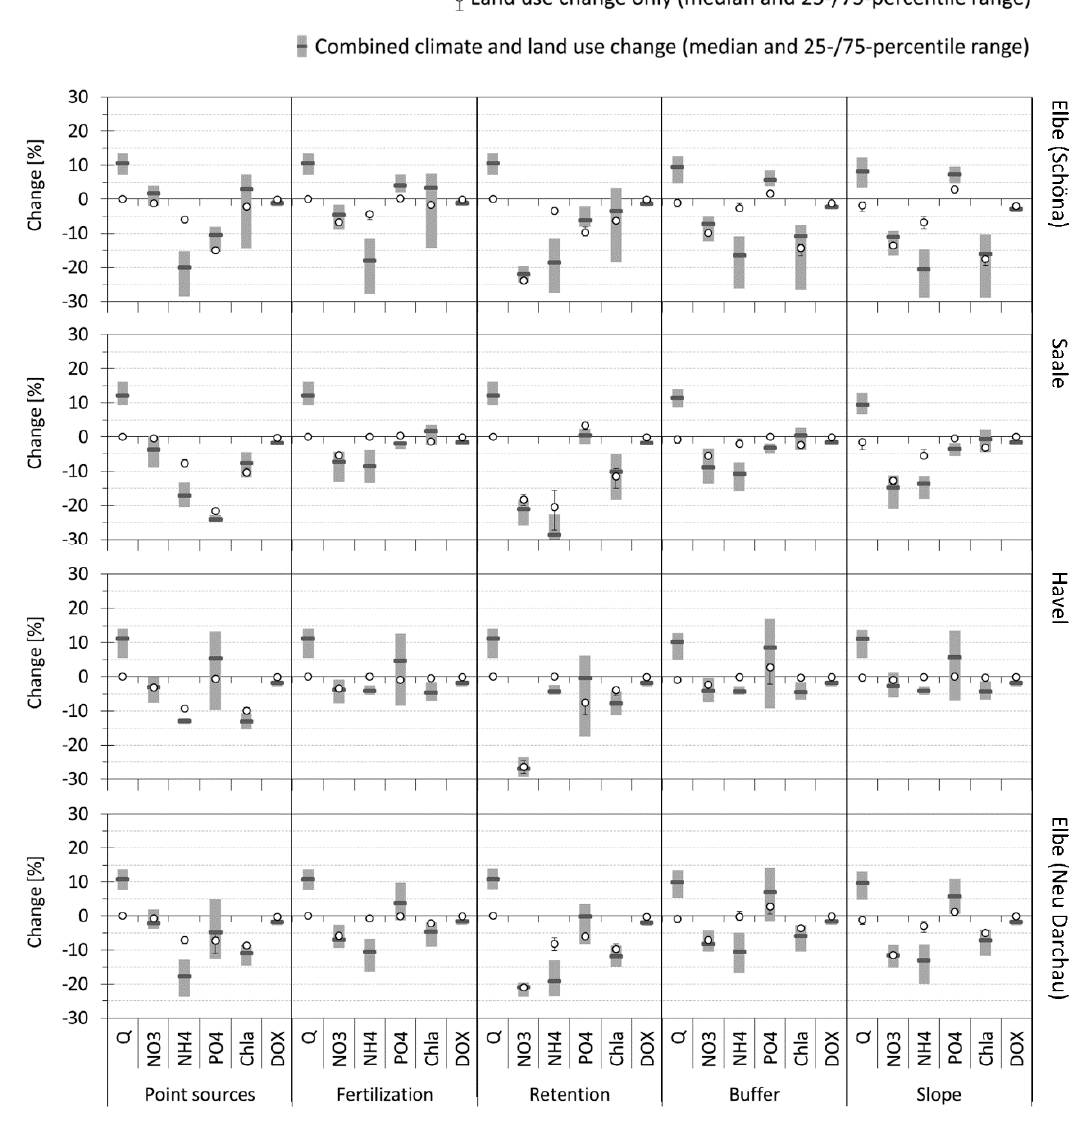
Figure 8. Impacts of socio-economic changes and combined climate and socio-economic changes on the average water discharge (Q), nutrient (NO 3 -N, NH 4 -N, PO 4 -P) and chlorophyll a (Chla) loads and dissolved oxygen concentrations (DOX) of the Elbe river at two stations and at two main German tributaries. The dark grey bars and white dots show the median of 19 percental changes together with their 25th/75th percentile ranges (light grey ranges and black whiskers).